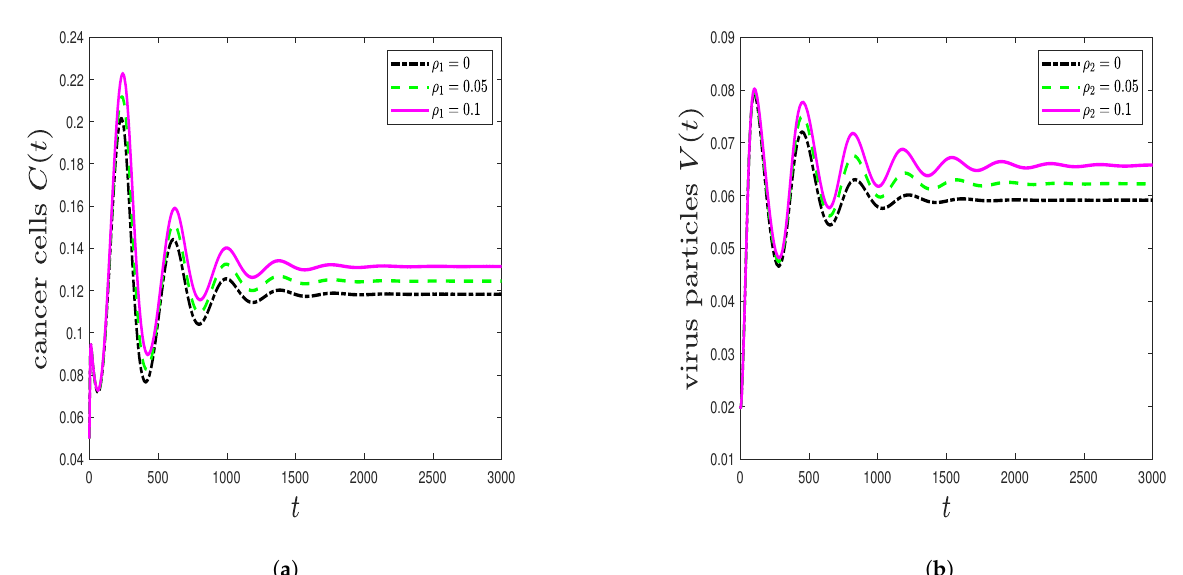
Figure 5. The effect of increasing ρ 1 and ρ 2 on the concentration of ( a ) cancer cells C ( t ) and ( b ) SARS-CoV-2 particles V ( t ) . The parameters are taken as η 1 = 0.9, η 2 = 0.5, η 4 = 1.7, η 5 = 1.7, κ 1 = 0.0001, κ 2 = 0.0003, κ 3 = 0.0003, κ 4 = 0.0001, and κ 5 =